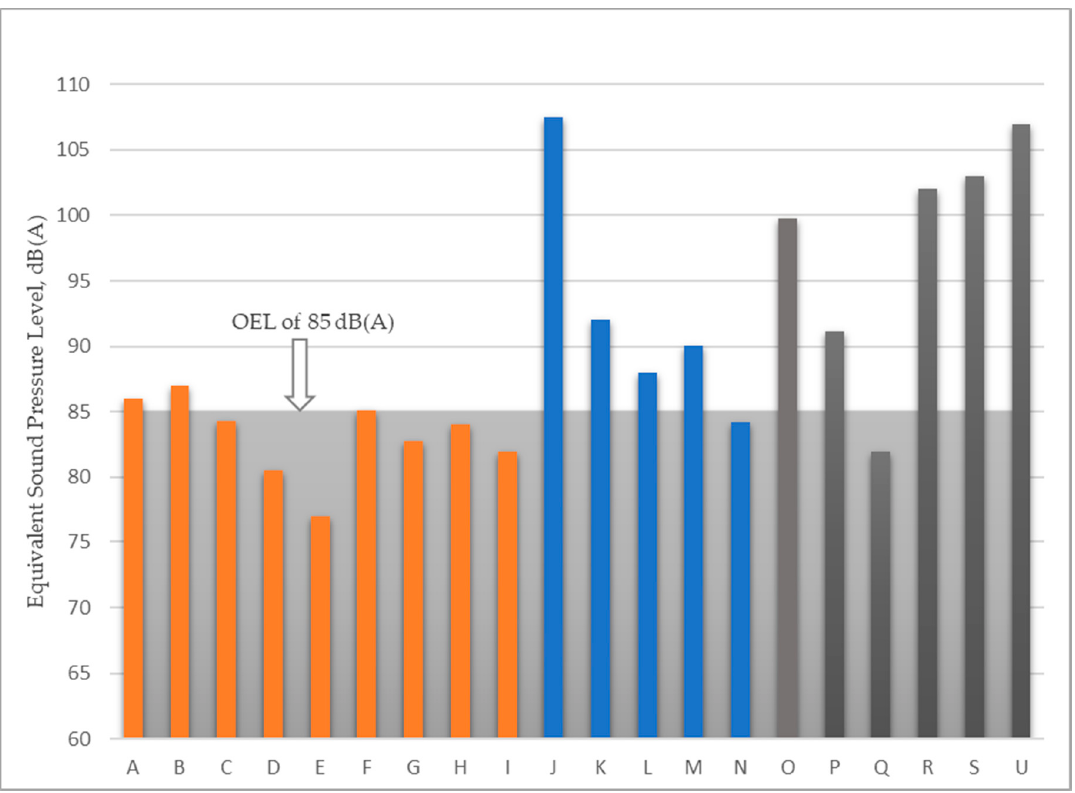
Figure 5. Personal daily dose (L EX , 8 h) at indoor sports and gymnasia halls compared with occupational exposure level (OEL) of 85 dB(A). Orange bars represent Category I, blue bars represent Category II, and grey bars represent Category III.